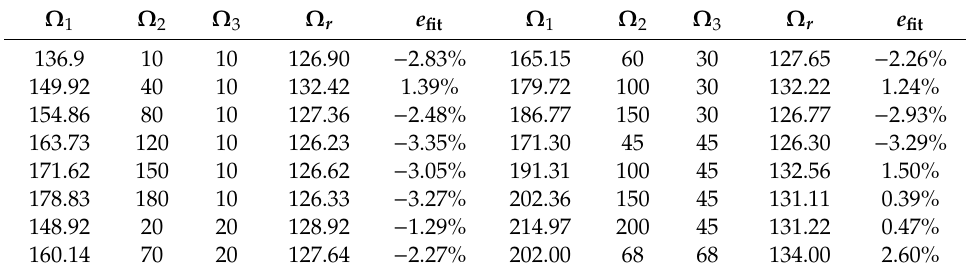
Table 3. Combined principal stresses of natural marble specimens and verifying data